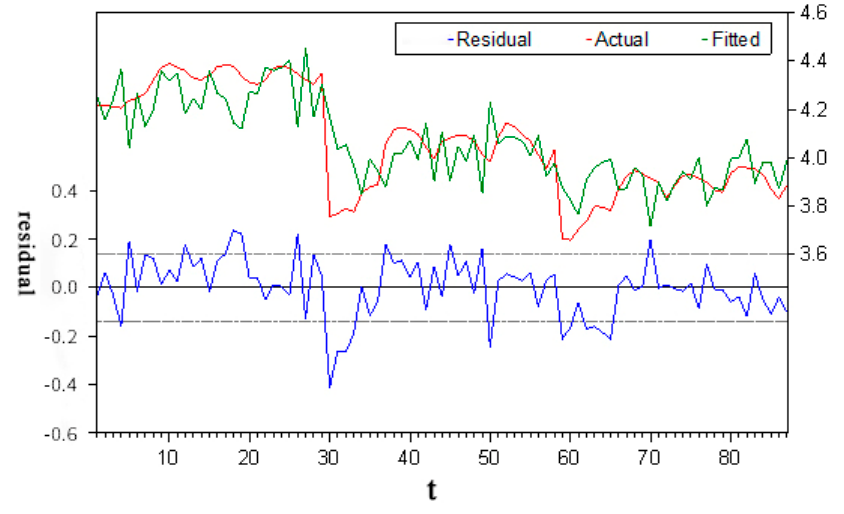
Figure 7. OLS regression fitting residuals.